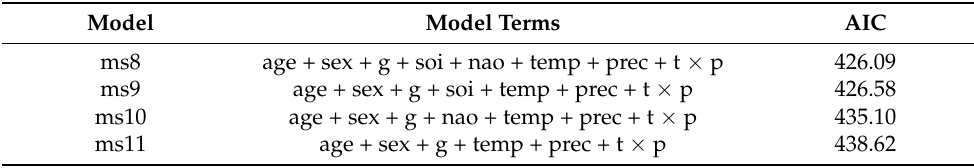
Table A2. Model selection for large-scale climate variables using Akaike information criterion (AIC) with all three local climate variables being